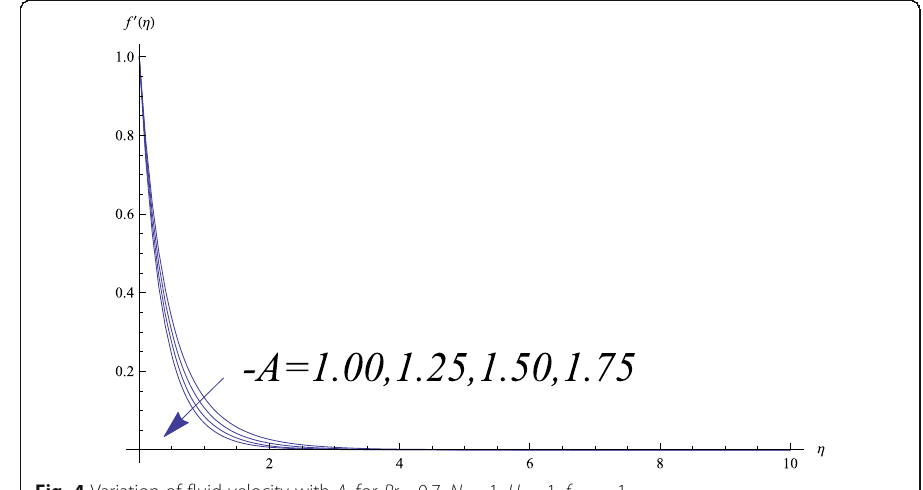
Fig. 4 Variation of fluid velocity with A , for Pr = 0.7, N R = 1, U 0 = 1, f 0 = − 1